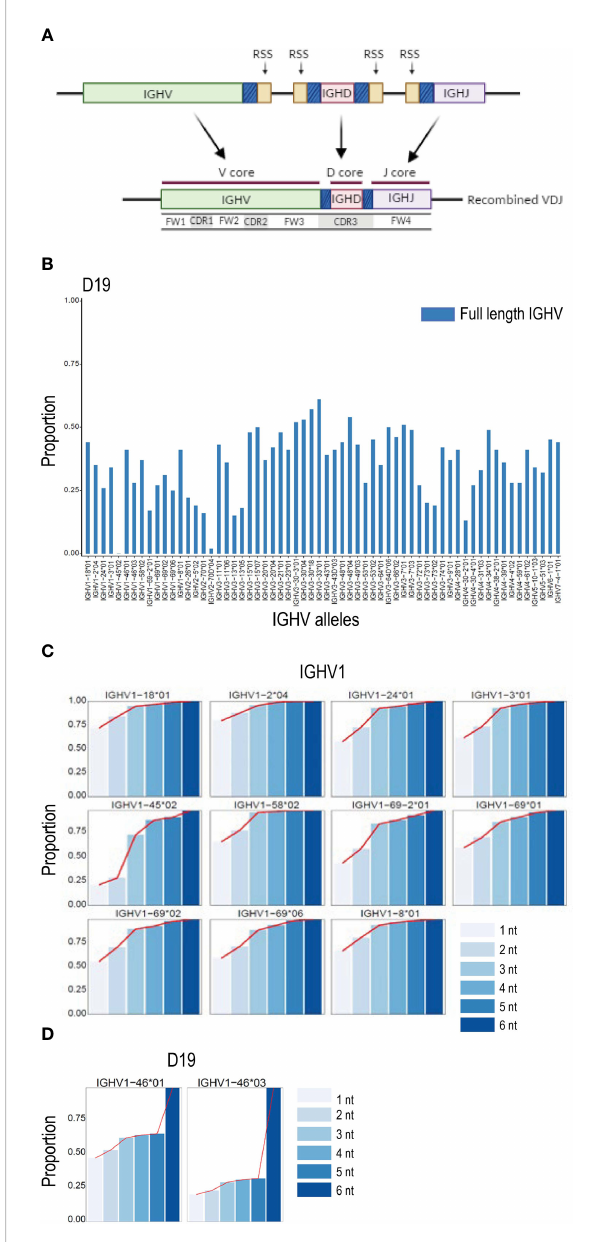
FIGURE 3 VDJ associated IGHV truncation. (A) Schematic of VDJ recombination. Genomically distinct V, D and J alleles are recombined to produce a unique VDJ ‘ exon ’ . The recombination process in most cases causes loss or replacement of several 3 ’ located nucleotides of the V gene, 5 ’ nucleotides of J genes and both 5 ’ and 3 ’ nucleotides of D genes, thereby enabling the generation of high levels of CDR3 coding diversity. The sections of the V, D and J genes subject to high rates of recombination associated change are denoted with a shaded blue color in the fi gure. The gene segments least affected by the recombination process are termed here the V, D and J core sequences. (B) Effect of recombination based 3 ’ nucleotide alteration on unmutated allele counts in D19 using NGS analysis of the IgM library. The proportion of counts for V alleles containing the entire V sequence are shown in blue. (C) The proportion of counts of a series of single